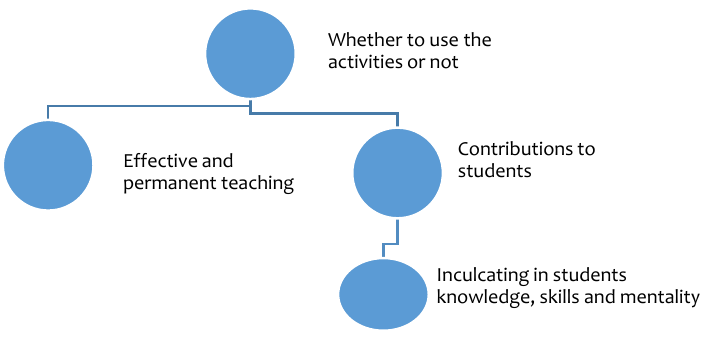
Figure 5. The Prospective teachers’ Views on whether or not to Use the Museum Education Activities in their Professional Life of